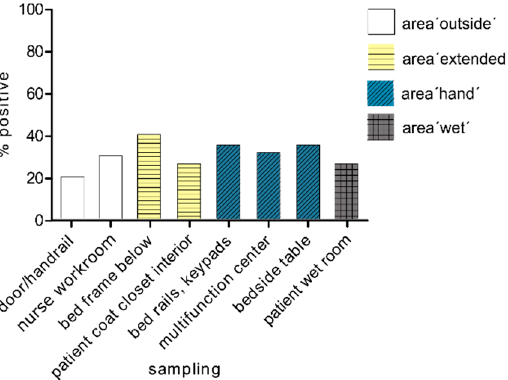
Figure 3. Spread after 72 h. Spread of carbapenemase-positive organisms within the four tested areas after 72 h of hospitalisation of the patient in the room ( n = 19–20).